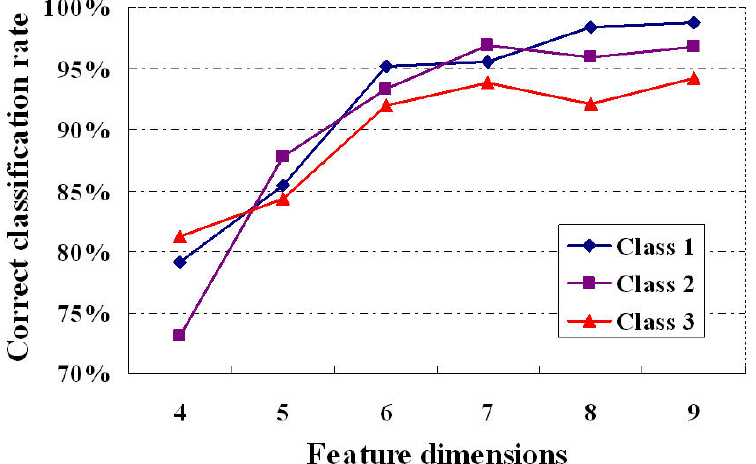
Figure 6. The correct classification rate of three classes with respect to PC